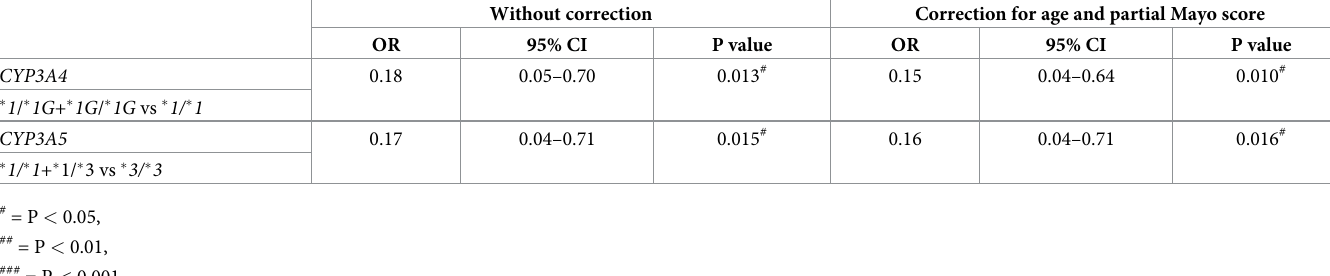
Table 5. Multivariate analysis of factors associated with efficacy at 1 week after tacrolimus treatment.